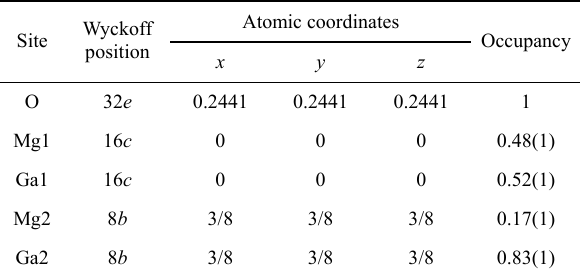
Atomic coordinates of spinel phase in Eu-doped MgGa 2 O 4 :Mn 2+ ,Eu 3+ ceramics ( a = 8.2726(1) Å, R-factor =